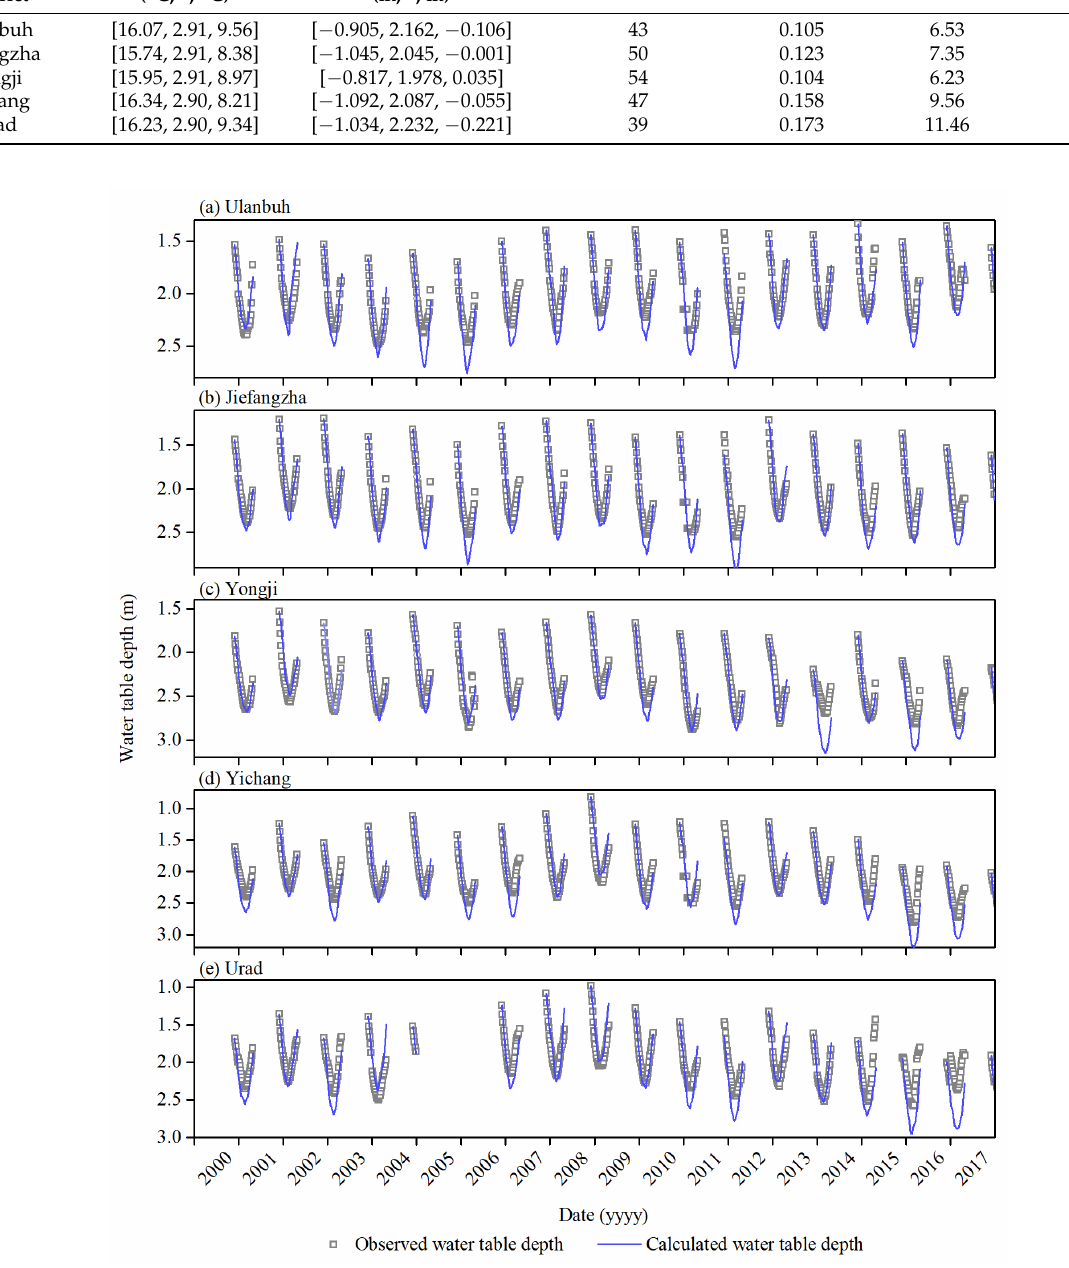
Table 1. Parameters and model evaluation indexes of the sub-model applied in Hetao Irrigation District. Sub-Irrigation District